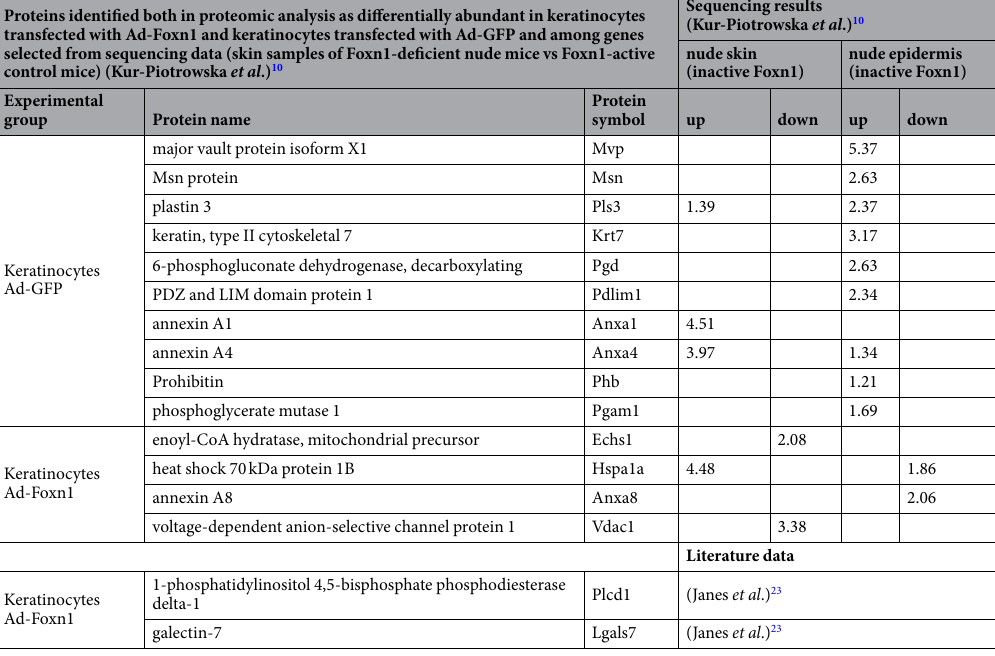
Table 2. Proteins identified both in proteomic analysis as differentially abundant in keratinocytes transfected with Ad-Foxn1 and keratinocytes transfected with Ad-GFP and among genes selected from sequencing data (skin samples of Foxn1-deficient nude mice vs Foxn1-active control